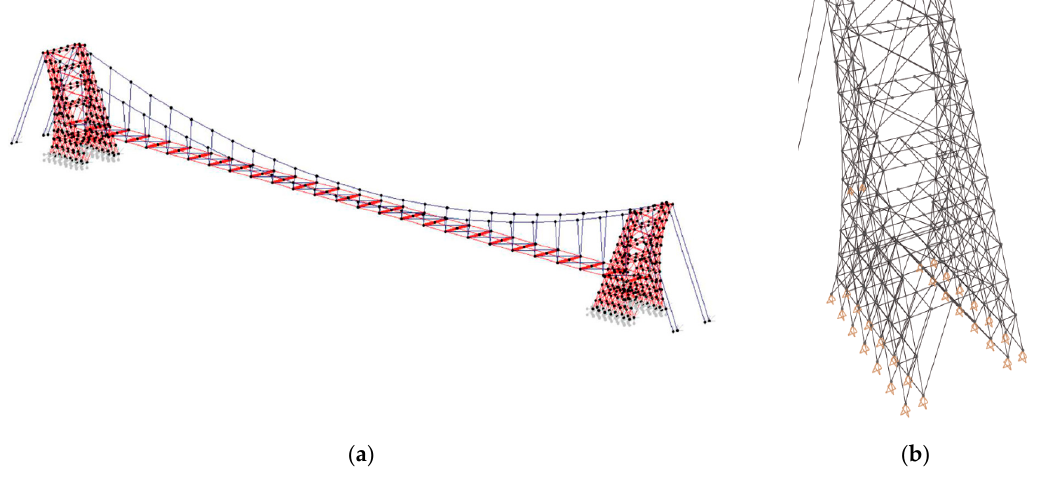
Figure 9. Structural FE model: global view ( a ) and tower detail ( b